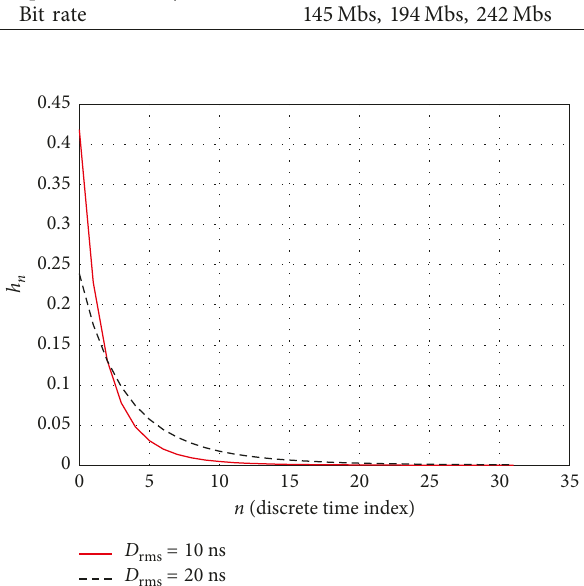
Figure 5: The normalized time domain CIR from ceiling bounce 10 , 20ns. model for D rms (cid:29)